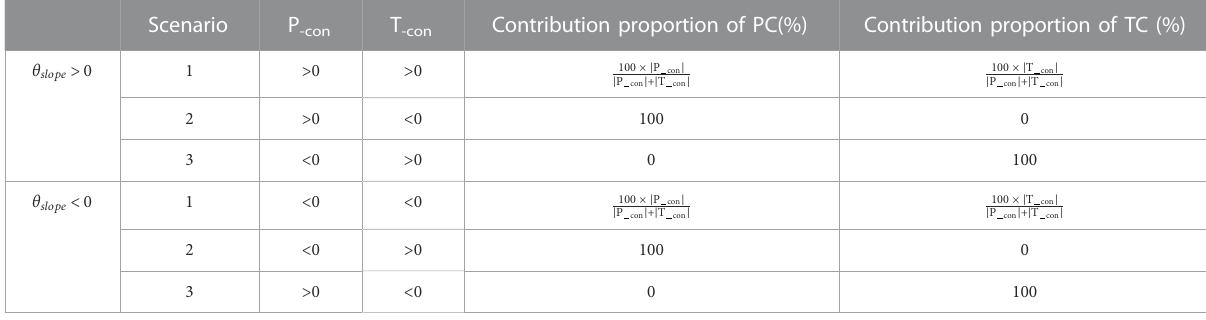
TABLE 2 Six scenarios for quantifying the contribution proportions of p and T to grassland restoration and degradation.